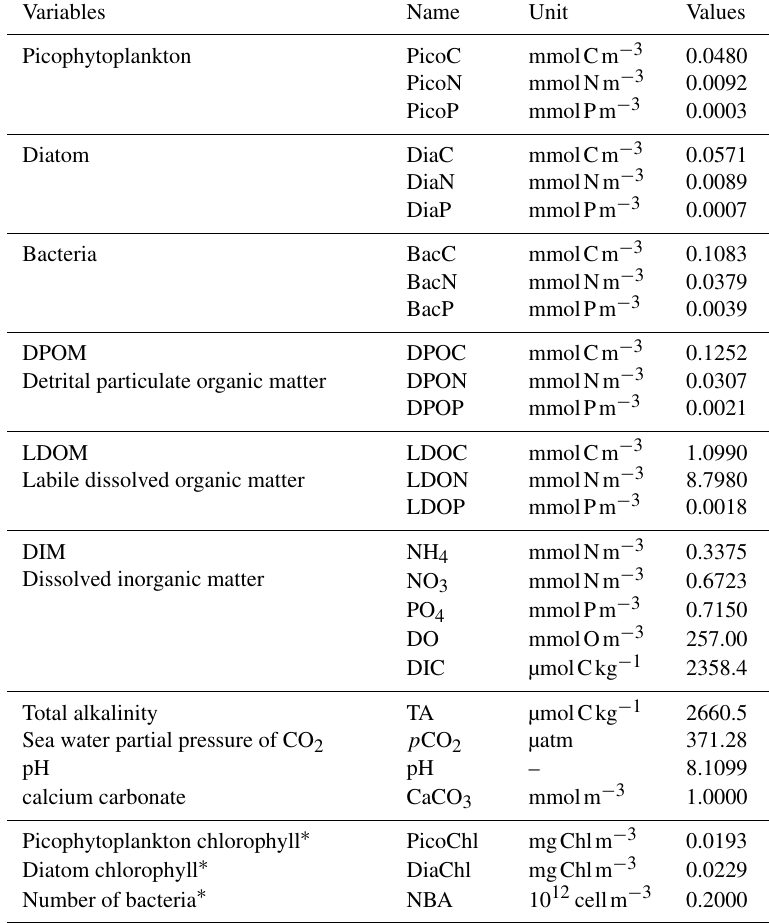
Table B1. Initial conditions of the state variables of the Eco3M-CarbOx